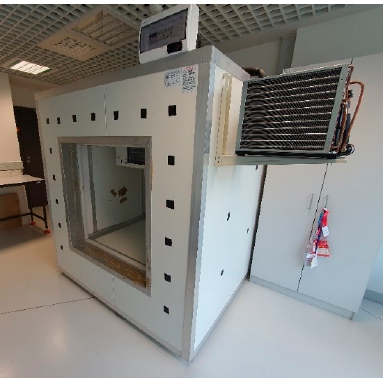
Figure 4. The climatic test chamber used to conduct experimental research.